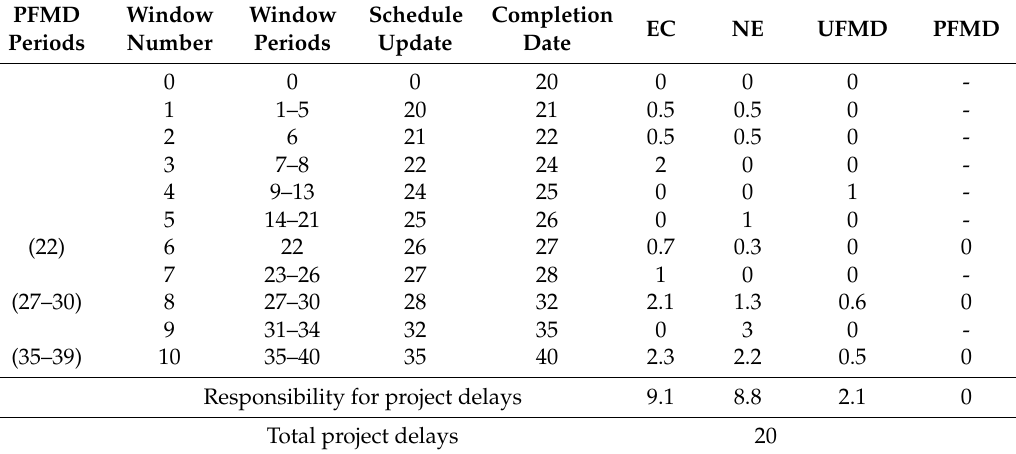
Table 8. The results of period (35–39) into the project delays.